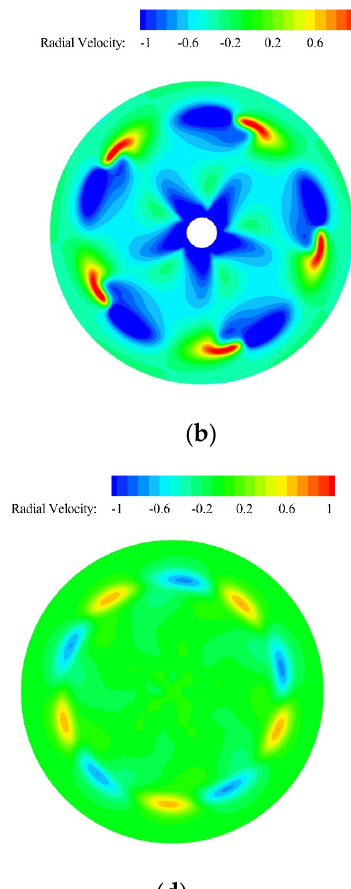
Figure 17. Radial velocity at J = 0.7: ( a ) iso-surface of V R = 0.6 m/s and X = 0 plane; ( b ) Z/R = − 0.5 plane; ( c ) Z/R = − 1.0 plane; and ( d ) Z/R = − 1.5 plane.